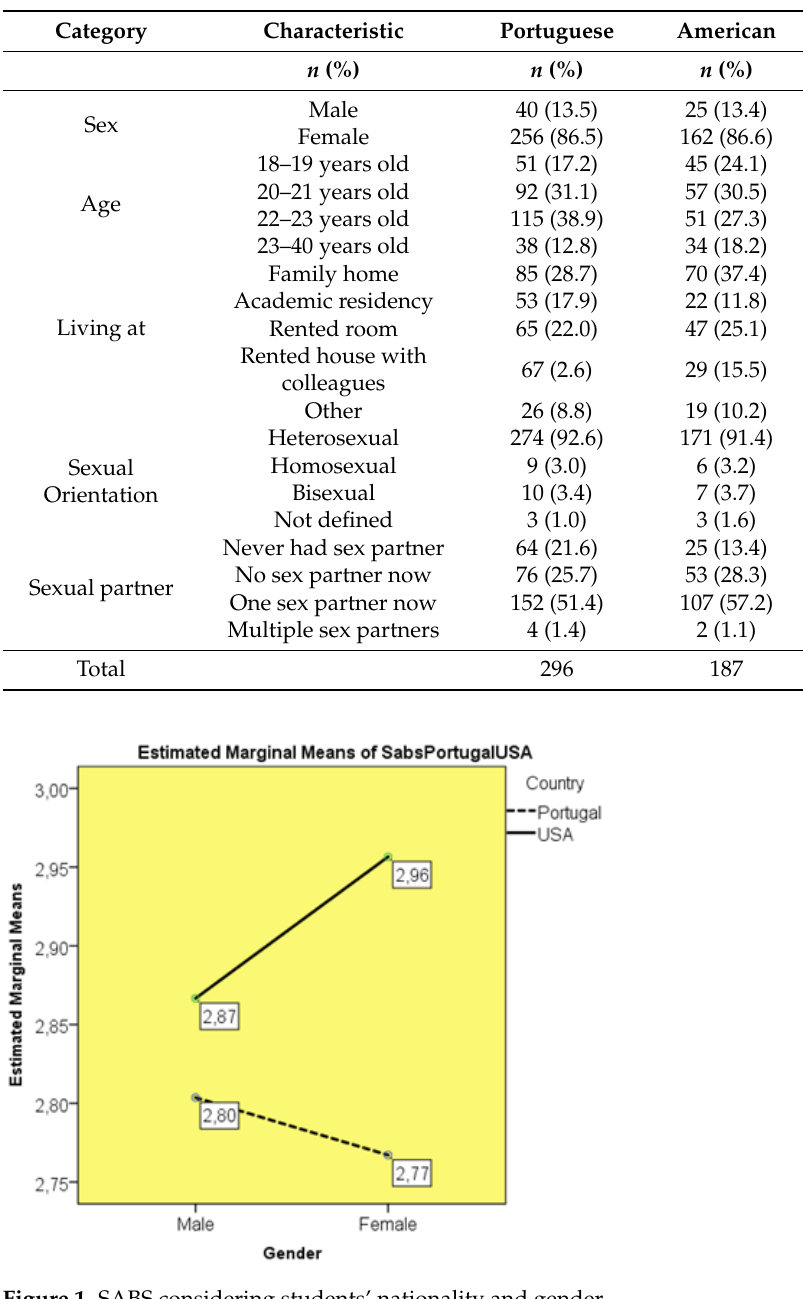
Figure 1. SABS considering students’ nationality and gender. Considering the students’ sexual orientation (heterosexual, homosexual and bisexual), excluding the three participants who did not define themselves, a new two-factor ANOVA test (i.e., nationality and sexual orientation) was performed. Levene’s test showed equality of variances ( p = 0.086). Without significant differences (F (5:287) = 1.906; p = 0.093), American students showed numerically higher means in the attitudes and beliefs towards sexuality of the patient when compared to the Portuguese (M = 2.863, SD = 0.160 vs. M = 2.772, SD = 0.109). It was observed that the most conservative about patient sexuality